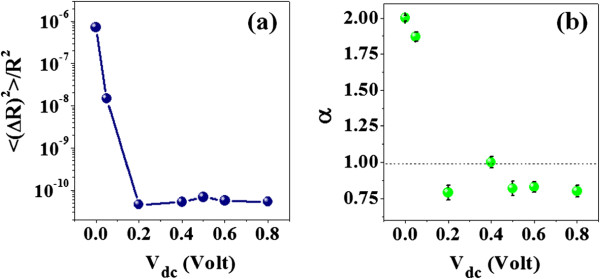
The variation of (a) 〈(ΔR)2〉 / R2 and (b) α as a function ofVdcat 300 K.